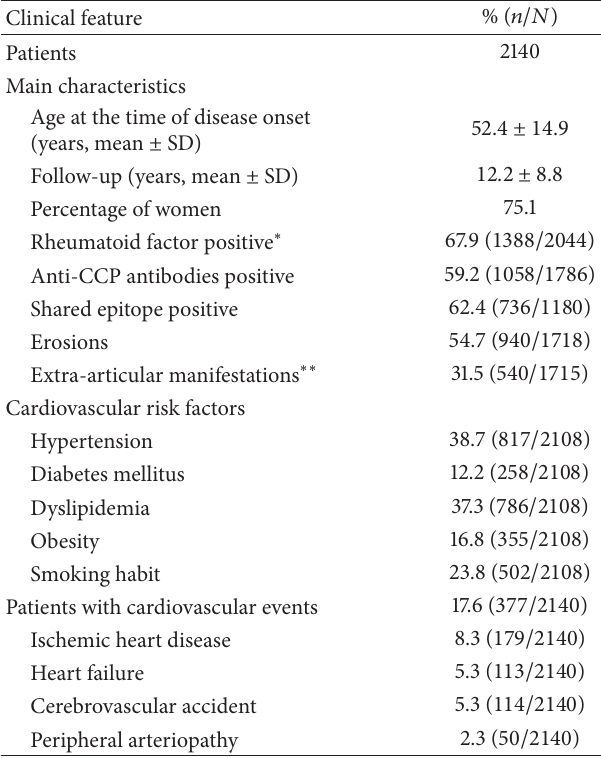
Table 1: Demographic and clinical characteristics of the Spanish patients with RA included in the